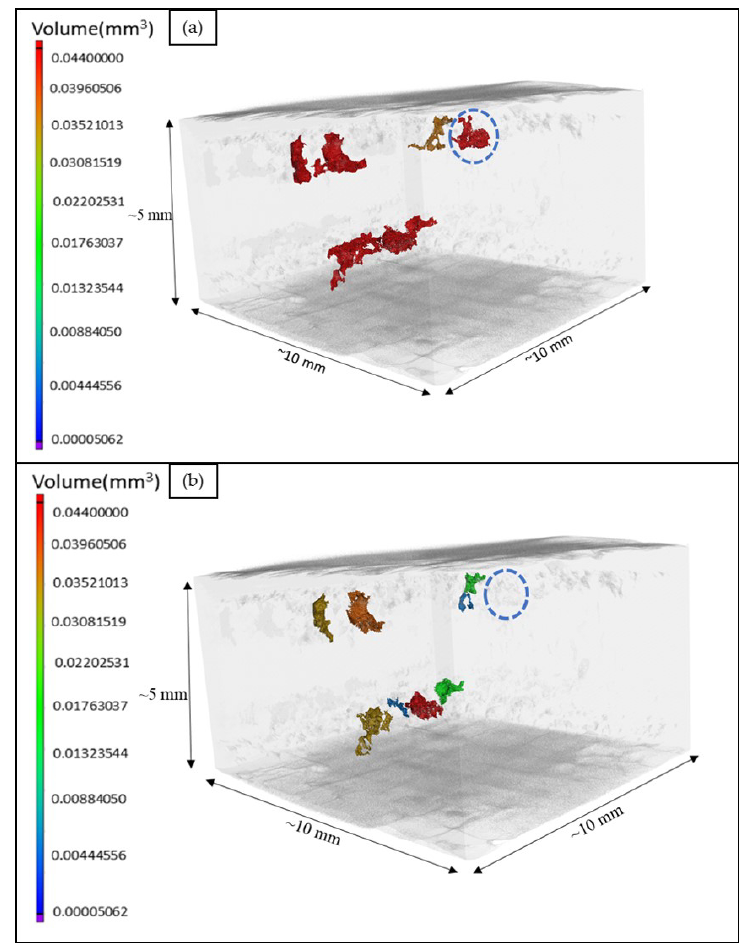
Figure 7. Three-dimensional (3D) views of large defects in the same coated sample ( a ) before and ( b ) after hot isostatic pressing (HIPing), obtained from x-ray computed tomography (XCT) analysis.